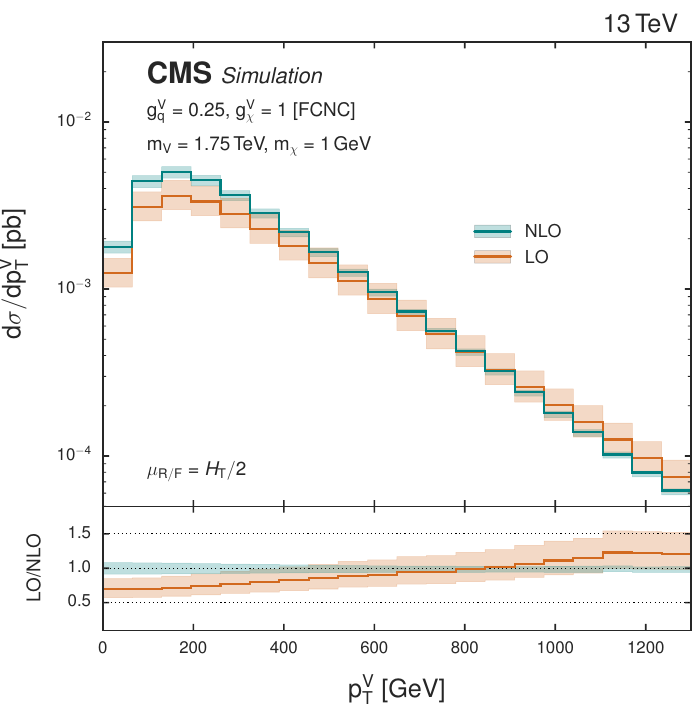
Figure 14 . Inclusive distribution of the transverse momentum of the mediator boson V in the FCNC monotop production mechanism, both at leading-order (LO) and next-to-leading order (NLO) accuracy in QCD, assuming couplings of g V and 1 GeV for V and the fermionic DM particle (cid:31) , respectively. Shaded bands around the central predictions correspond to independent variations of the nominal factorization and renormalization scale H T = 2 by factors of 2 and 1 = 2. While the NLO case exhibits a softer spectrum for p V LO computation, which should result in a relatively softer p miss by about 25% (from 24.8 fb at LO to 31.4 fb at NLO).